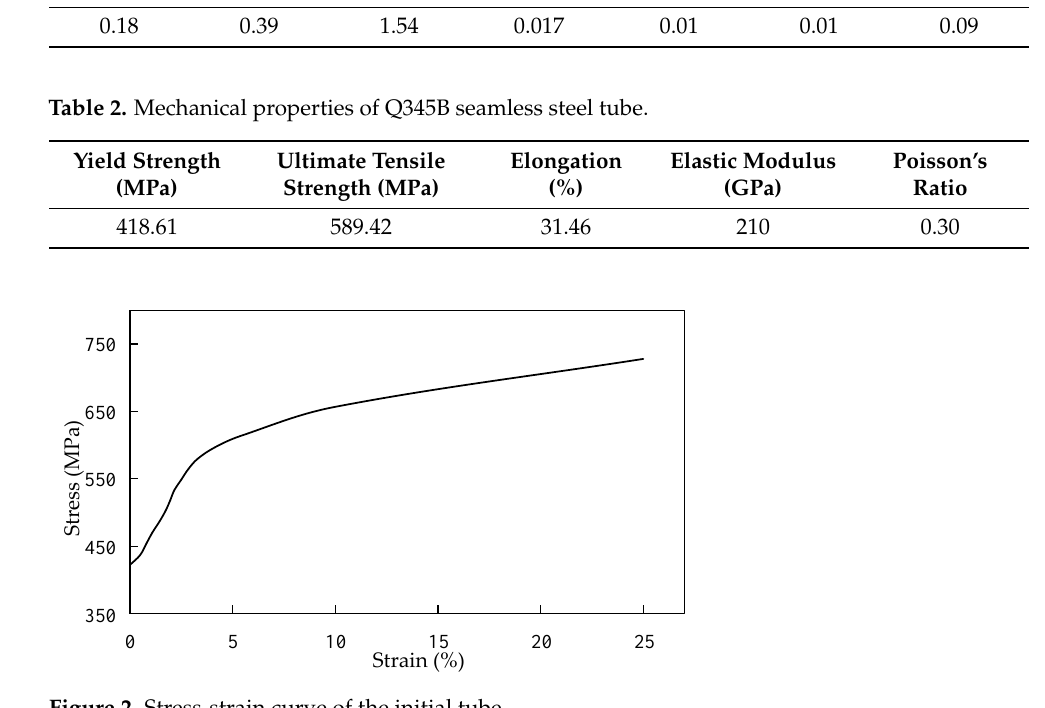
Table 1. Chemical composition of the Q345B seamless steel tube (%).